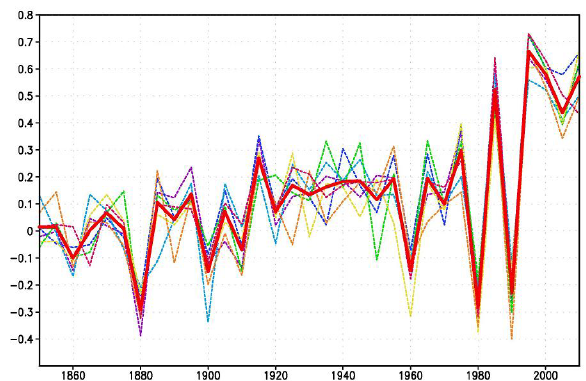
Figure 3. The 5-year mean surface heat flux; Wm − 2 (positive downward). The thick solid red line represents model mean, and the dashed thin lines represent data from individual model runs: 1 – purple, 2 – dark blue, 3 – blue, 4 – green, 5 – yellow, 6 – orange, 7 –